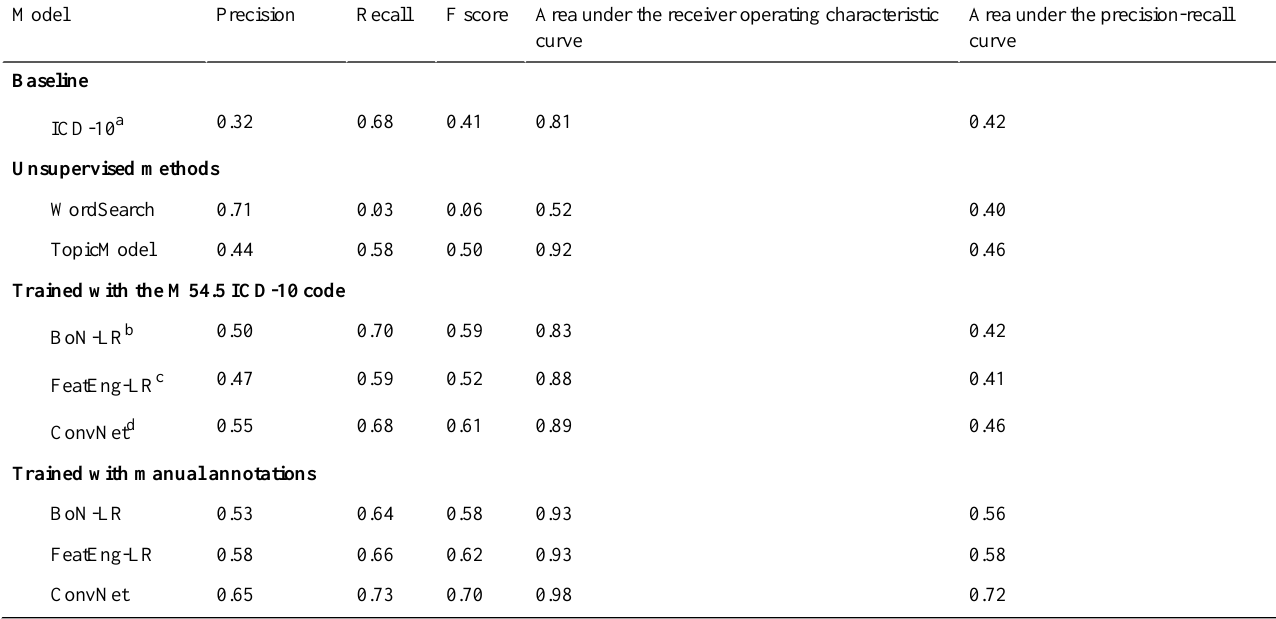
Table 1. The classification results in identifying clinical notes with acute low back pain (LBP) episodes averaged over the 10-fold cross-validation experiment. We compared different supervised and unsupervised strategies: keyword search (WordSearch), topic modeling (TopicModel), logistic regression with bag of n-grams (BoN-LR) and manual features (FeatEng-LR), and deep learning (ConvNet). The supervised models (ie, BoN-LR, FeatEng-LR, and ConvNet) were trained using manual annotations or M54.5 International Classification of Diseases, 10th revision (ICD-10) codes. The ICD-10 baseline simply considered as acute LBP all the notes associated with the generic M54.5 Low back pain ICD-10 code.